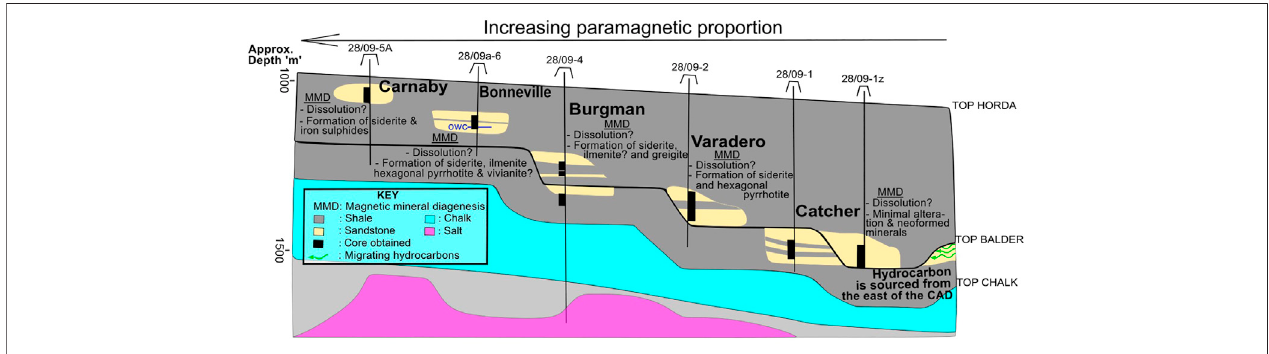
FIGURE 12 | A schematic (approximately W-E) cross-section through the CAD fi elds showing the variation in paramagnetic proportion and the distribution of magnetic minerals. Approximate horizontal extent of section is 30 km. Dissolution of ferromagnetic minerals and formation of paramagnetic minerals is the general consequence of hydrocarbon accumulation. Hydrocarbon migration direction and oil saturation has the dominant in fl uence on the present-day magnetic